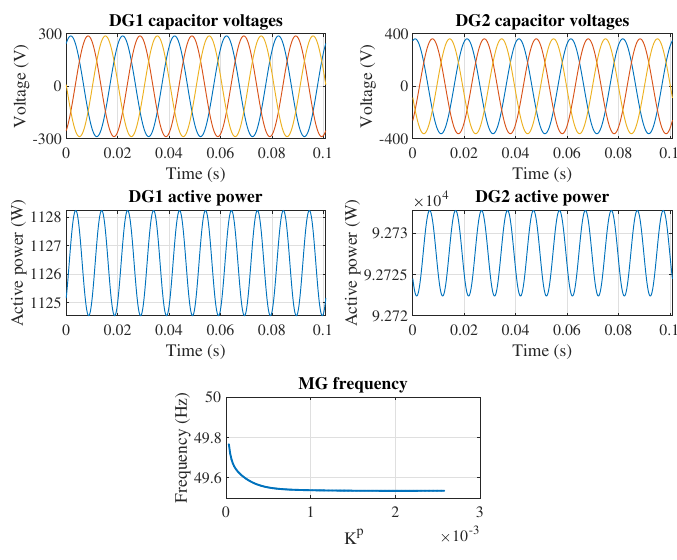
Figure A1. Time-domain simulation of five full-cycles of the computed unstable solution in Case 1, before the system collapses. Additionally, the system frequency during the whole K p